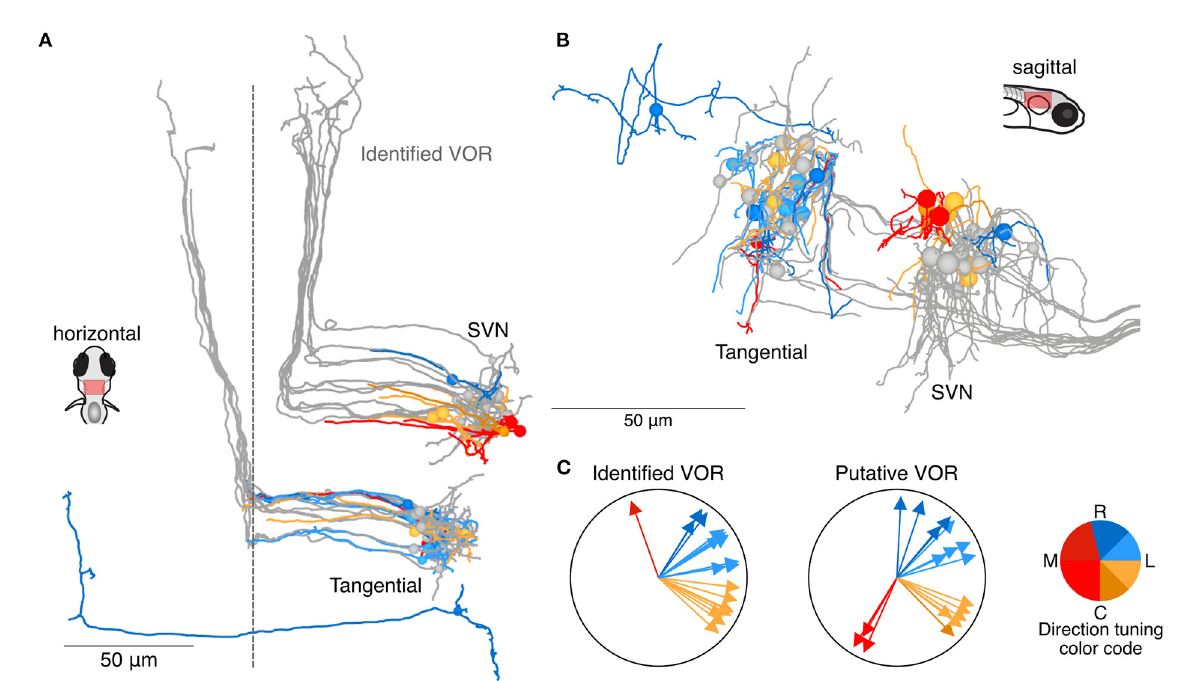
FIGURE5 Utricular-recipient neurons putatively involved in the VOR. (A) Horizontal projection of reconstructions of 11 identified tangential nucleus and 12 identified superior vestibular nucleus neurons (grays) along with 11 putative tangential and 6 putative SVN neurons that receive direct utricular input (colors). Neurons were identified as putative VOR neurons based on soma position and initial axon trajectory. One putative tangential nucleus neuron (dark blue, caudally located) was identified based on apparent homology to commissural neurons described by Bianco et al. (B) Sagittal view of the same neuron reconstructions as in (A) . (C) Summary of the inferred directional tuning of identified (left) and putative (right) VOR neurons with utricular